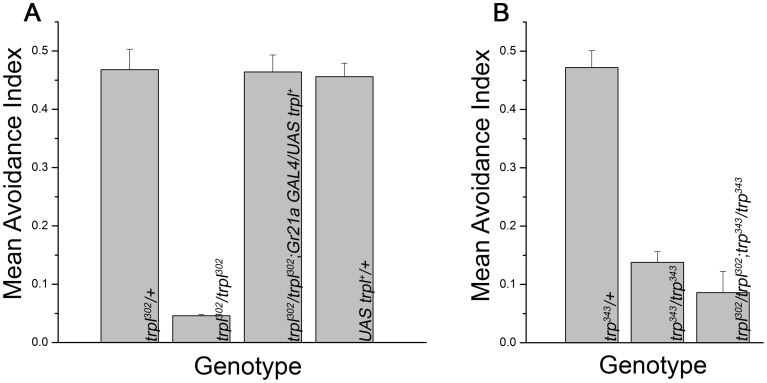
Null mutants of trp and trpl show reduced behavioral avoidance towards CO2.A) The mean avoidance index towards 5% CO2 in a Y-maze behavioral assay is shown for the indicated genotypes. The ability of trpl null homozygotes (trpl302/trpl302), to discriminate between 5% CO2 and air is significantly reduced (p<0.0001) as compared to the heterozygous control. The phenotype of the null mutant is rescued by expressing a wild type trpl transgene in Gr21a receptor neurons (trpl302/trpl302; Gr21a GAL4/UAS trpl+) (p<0.0001). B) Null mutant of trp (trp343/trp343) has reduced avoidance to 5% CO2 in the Y-maze assay. The avoidance response of the double null mutant (trpl302/trpl302; trp343/trp343) is also reduced but not significantly different from the single null homozygotes (p>0.05). Error bars indicate SEM in A and B.